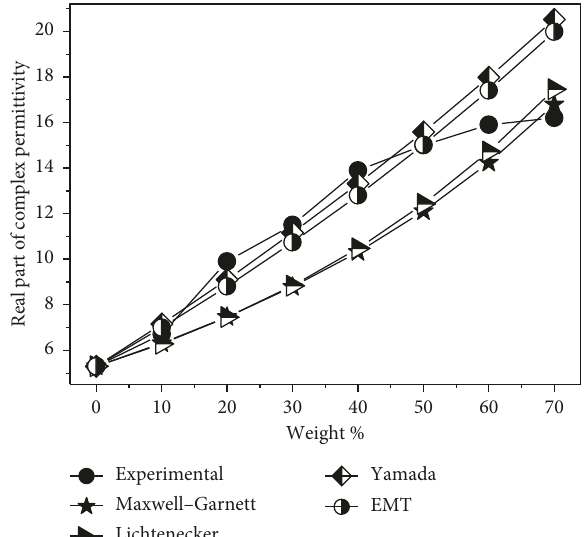
Figure 6: Real part of complex permittivity of the composite samples, as a function of the weight fraction of CCTO, obtained for the 5GHz cavity, and respective fitting using four classic mixing